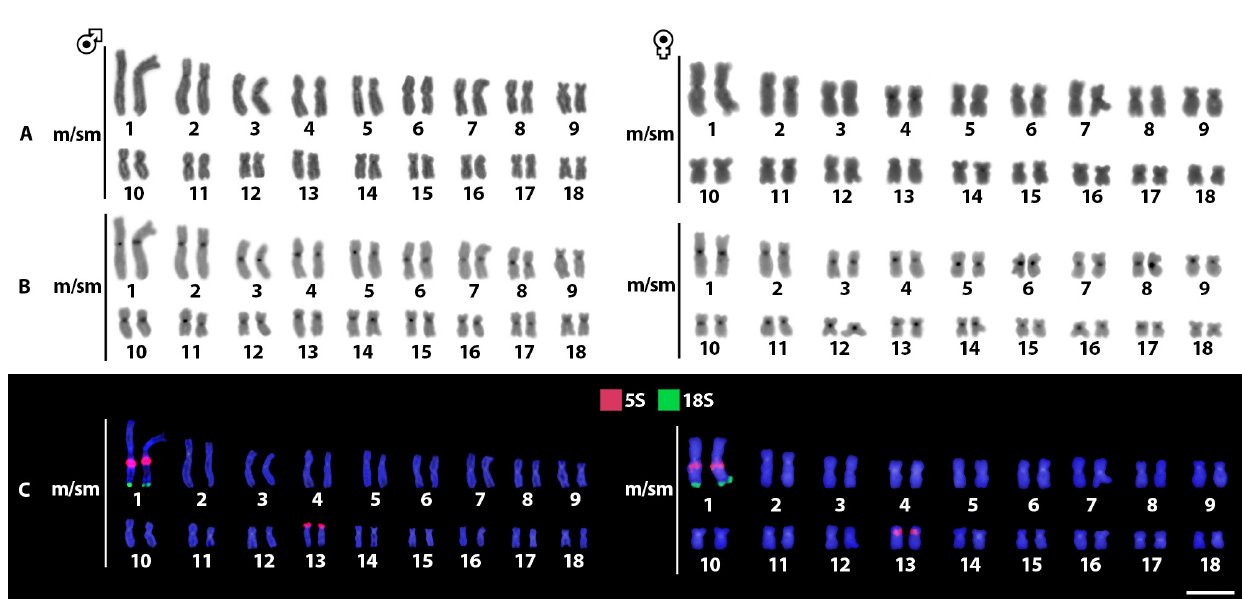
FIGURE 2 | Male and female karyotypes of Lebiasina minuta after A. Giemsa staining, B. C-banding, and C. “double-FISH” with 5S (red) and 18S (green) rDNA probes. Scale bar = 5